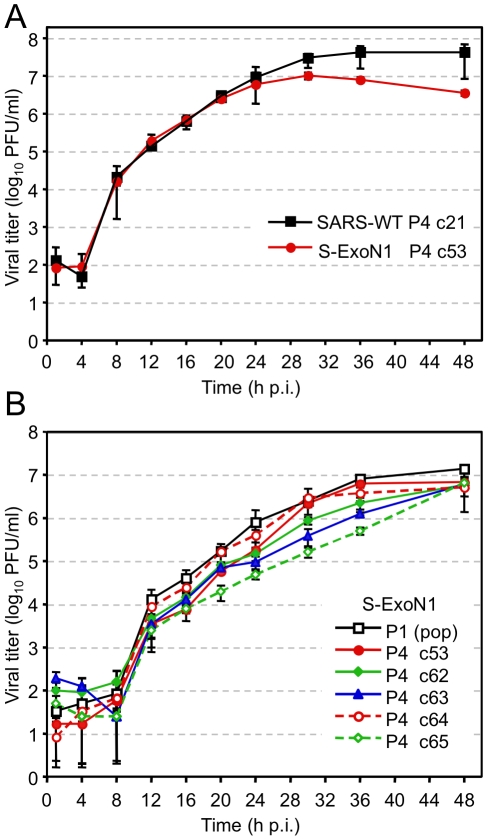
Growth analysis of viral replication.Growth comparisons of SARS-WT and S-ExoN1 viruses (A), and of multiple S-ExoN1 clones and S-ExoN1 population virus (B). (A) Vero cells were infected with SARS-WT P4 c21 and S-ExoN1 P4 c53 viruses at an MOI of 0.1 PFU/cell. (B) Vero cells were infected with P1 population stock of S-ExoN1 or S-ExoN1 P4 clones (c53, c62, c63, c64, and c65) at an MOI of 0.01 PFU/cell. Samples of culture medium were obtained at 1, 4, 8, 12, 16, 20, 24, 30, 36, and 48 h p.i., and viral titers were determined by plaque assay. Mean titers and standard deviations from triplicate infection series are indicated for each time point.